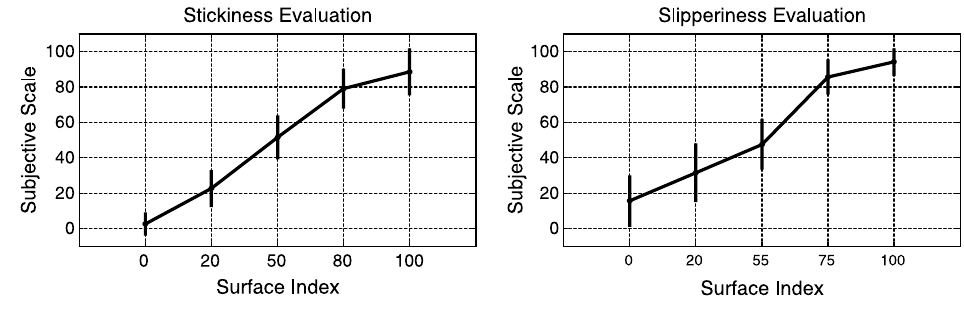
Fig. 2. Mean subjective scales for different samples; Error bars represent 95% confidence